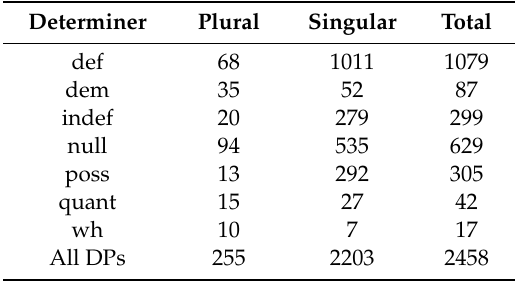
Table 4. Distribution of DPs by determiner and number (all tokens).